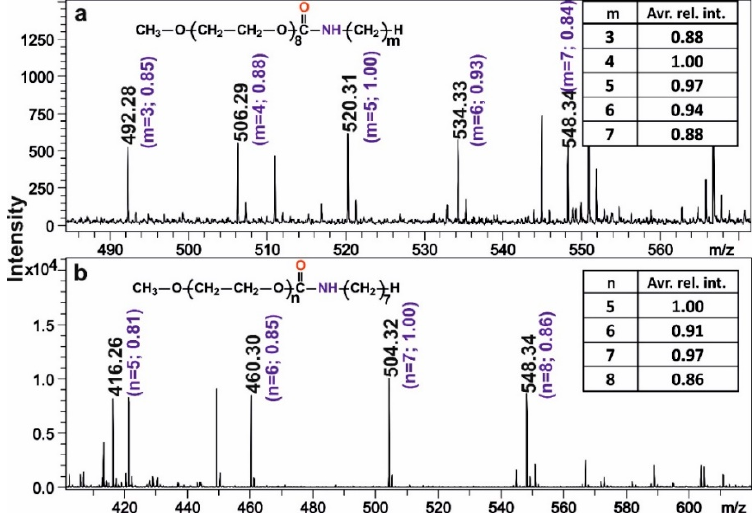
Figure 2. MALDI-TOF MS spectra and intensities of mPEG-OCONR oligomers with mPEG 8 and alkylisocyanates (m = 3 to 7) ( a ) and alkylisocyanate with m = 7 and mPEG n ( n = 5 to 8) ( b ). Numbers in the brackets indicate the relative intensities for the case of ( a , b ) while the inset tables show the average relative intensities by taking into account the other members of the series.